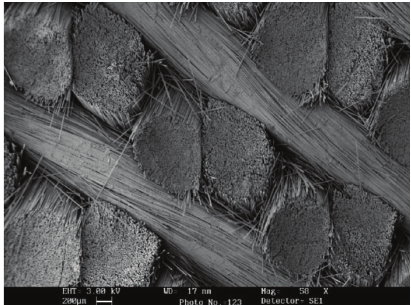
Figure 4: SEM micrograph of interior preforms